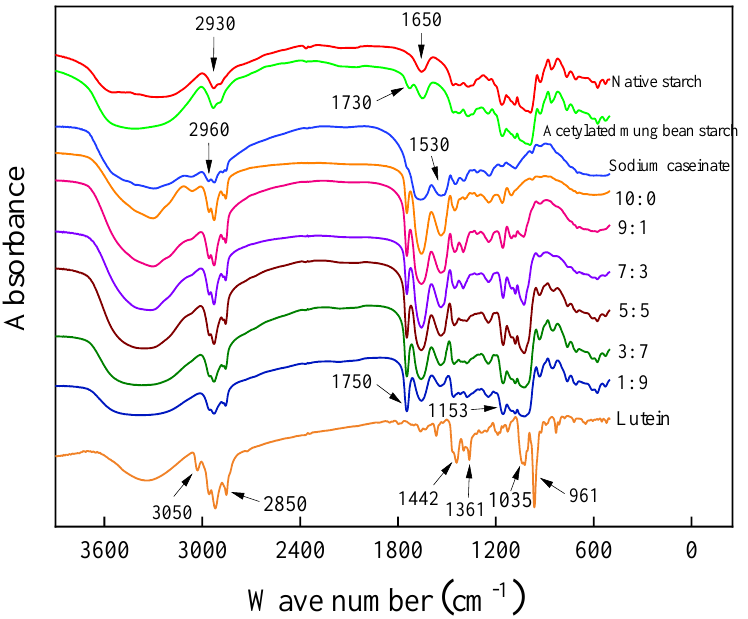
Figure 4. FTIR spectra of sodium caseinate-acetylated mung bean starch–lutein microcapsules. 10:0, 9:1, 7:3, 5:5, 3:7, and 1:9, respectively, represent the weight ratio of sodium caseinate and acetylated mung bean starch.